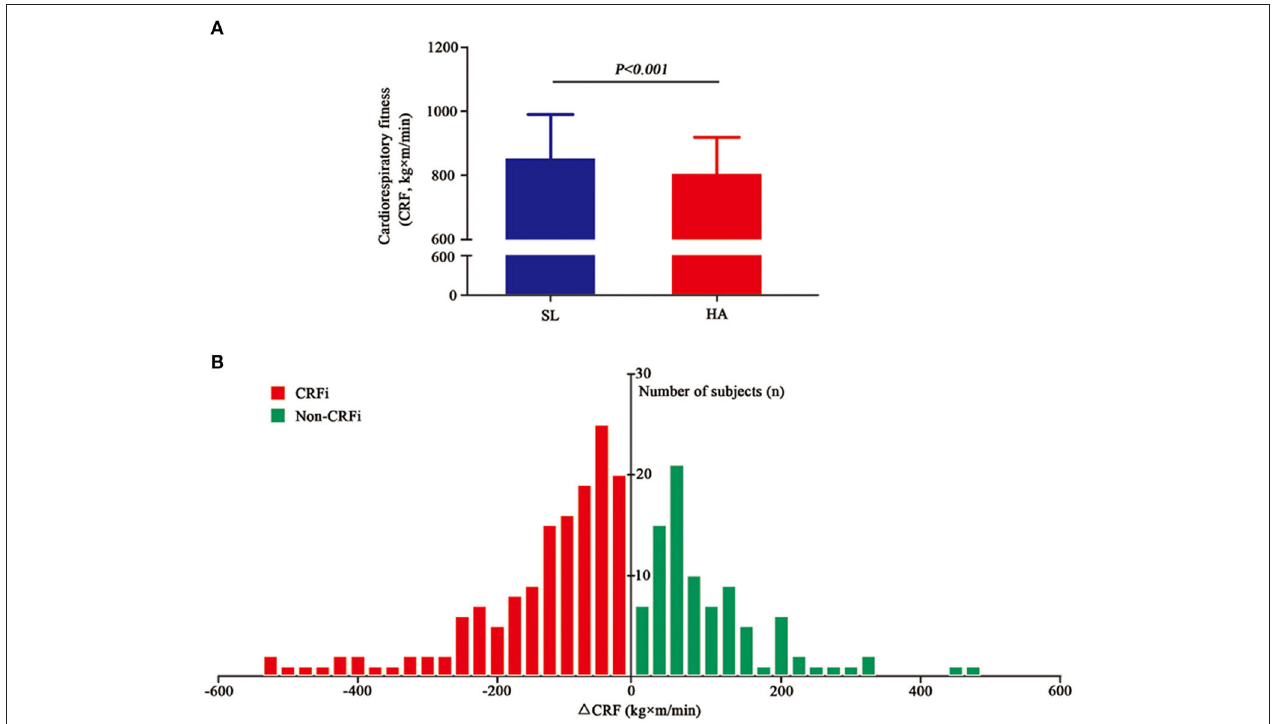
FIGURE 2 | Cardiorespiratory fitness at SL and HA. (A) The cardiorespiratory fitness significantly reduced from 829.50 (761.15–908.31) kg × m/min at SL (blue histogram, < 500m) to 798.83 (748.83–821.27) kg × m/min after acute high-altitude exposure (HA) (red histogram, 3,700m, asl), p < 0.001. (B) The changes in cardiorespiratory fitness after acute high-altitude exposure. The x-axis represents the values of change in cardiorespiratory fitness. The red histogram represents the number of subjects who experienced CRFi, while the green histogram represents the number of subjects whose cardiorespiratory fitness improved. Values are presented as medians (range interquartile). CRFi, cardiorespiratory fitness impairment; SL, sea level; HA, high altitude; asl, above the sea